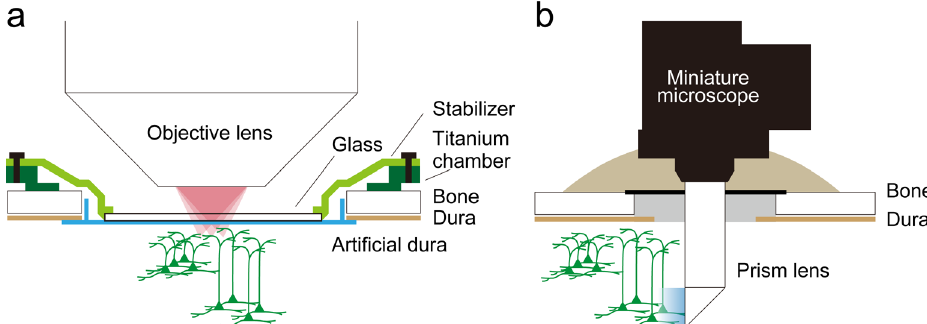
Fig. 1 Two con fi gurations of calcium imaging in the macaque motor cortex. a Con fi guration of two-photon imaging by Trautmann et al. It is possible to image the activity of multiple dendrites in the super fi cial layer of the cortical region under a large cranial window. The same and/or different fi elds can be imaged across days. The head of the macaque should be fi xed. b Con fi guration of one-photon miniscopic imaging by Bollimunta et al. Chronic calcium imaging of multiple neurons in the same deep-layer fi eld is possible. This is applicable to free-moving